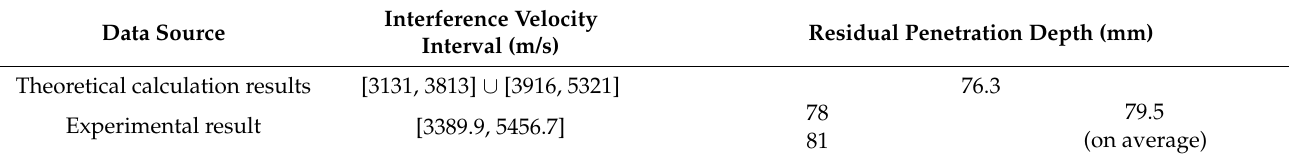
Residual Penetration Depth (mm)